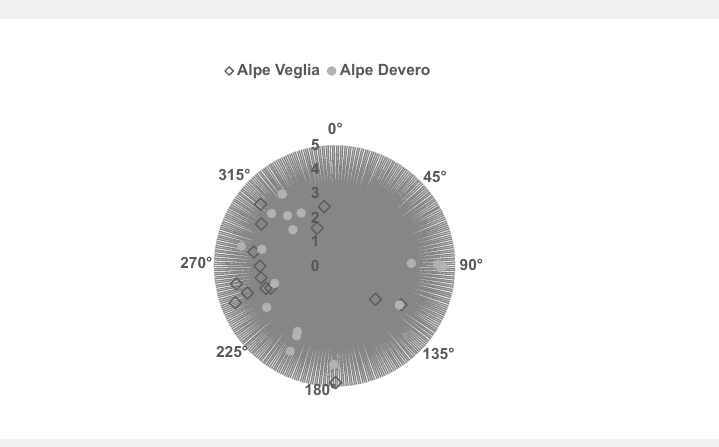
Figure 4 Relation between the host tree circumference (m) and aspect (azimuth). Note that nine of 24 host trees in Alpe Veglia do not have an aspect because they are located in Veglia Plain.